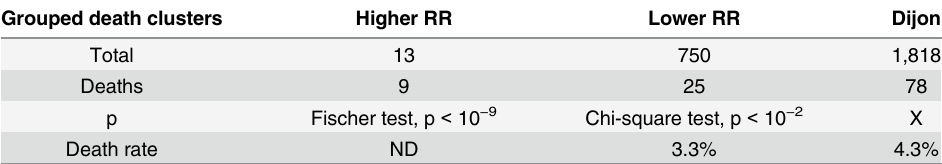
Table 7. Deaths in the mortality-based clusters in 1440. Grouped death clusters Higher RR Lower RR Dijon Total 13 750 1,818 Deaths 9 25 78 p Fischer test, p < 10 − 9 Chi-square test, p < 10 − 2 X Death rate ND 3.3% 4.3% Legend: Line 1: Grouped death clusters (or Dijon). Line 2: total number of households (deaths and survivors). Line 3: number of deaths (grouped and non-grouped). Line 4: result of the statistical test comparing the cluster(s) with the rest of the city. Line 5: death rate as percent. Column 2: pooled data from the 2 clusters of higher grouped death relative risk. Column 3: data from the cluster of lower grouped death relative risk. Column 4: data for the whole city. ND: not done. For each cluster, data of the control (rest of the city) can be computed by subtraction from the data of the whole